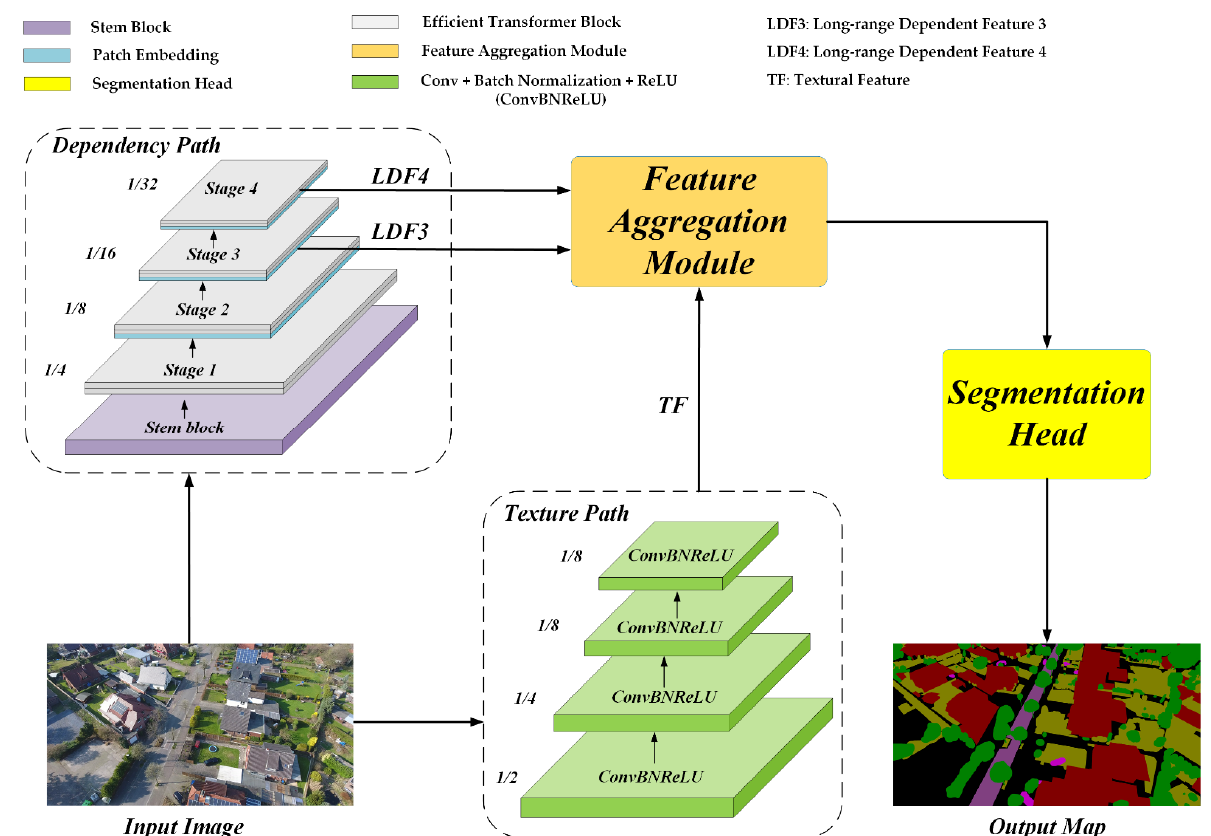
Figure 2. The overall architecture of Bilateral Awareness Network (BANet).